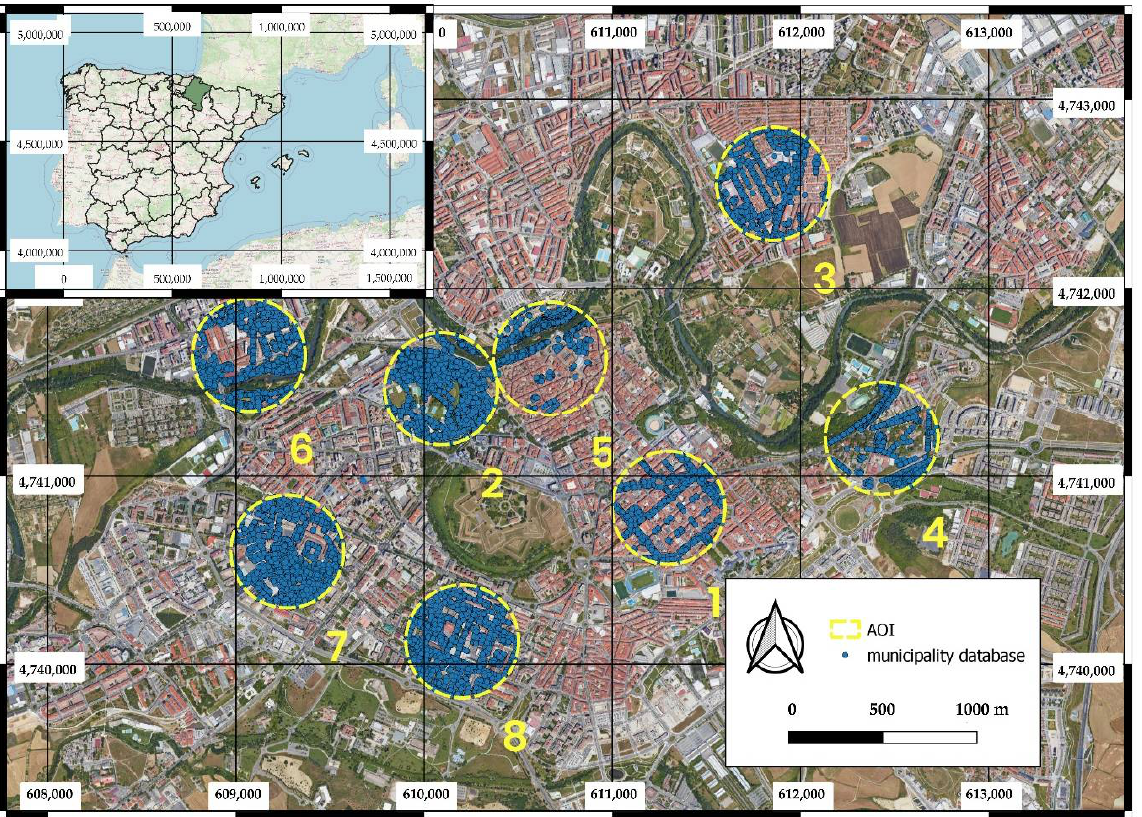
Figure 1. Location of the methodology analysis circles within the city of Pamplona. Circles 1, 2, 3, 6, and 8 were considered fully suitable for vehicles. The rest of the circles (4, 5 and 7) were either pedestrian areas or were residential areas with private gardens.